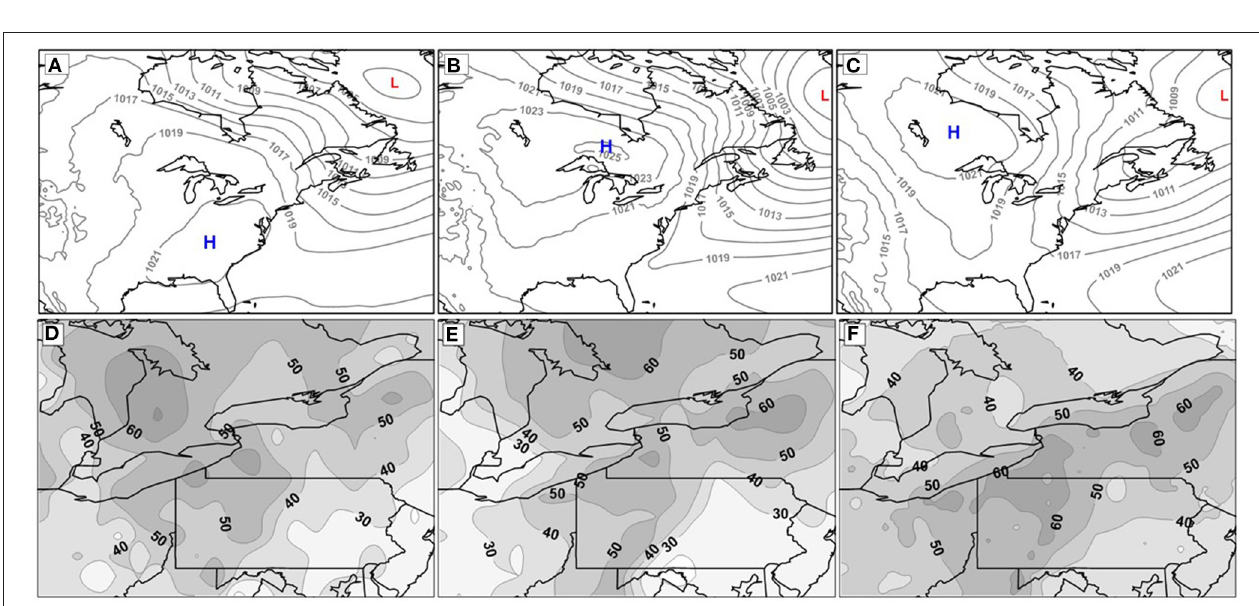
FIGURE 4 | Percentage of lake-effect days with precipitation in early-season (left column), mid-season (middle column), and late-season (right column) for days identified by both TSI and SSC methods (A–C) , and for TSI-defined days uncorroborated by SSC data (D–F) , 1964–65 through 2014–15. Contours are in 10% intervals.